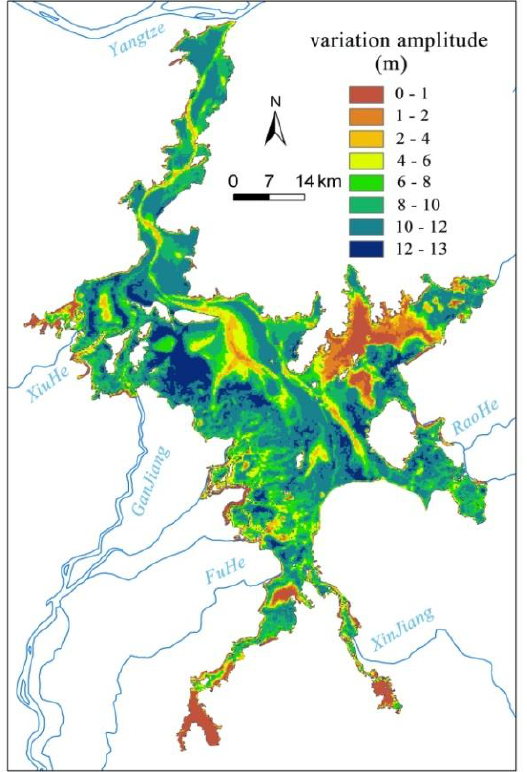
Figure 6. Mean water level variation amplitude (unit: m) between high-water and low-water periods during a year. The darker blue color indicates a higher amplitude of variation, and the darker red color indicates a lower amplitude of variation in a